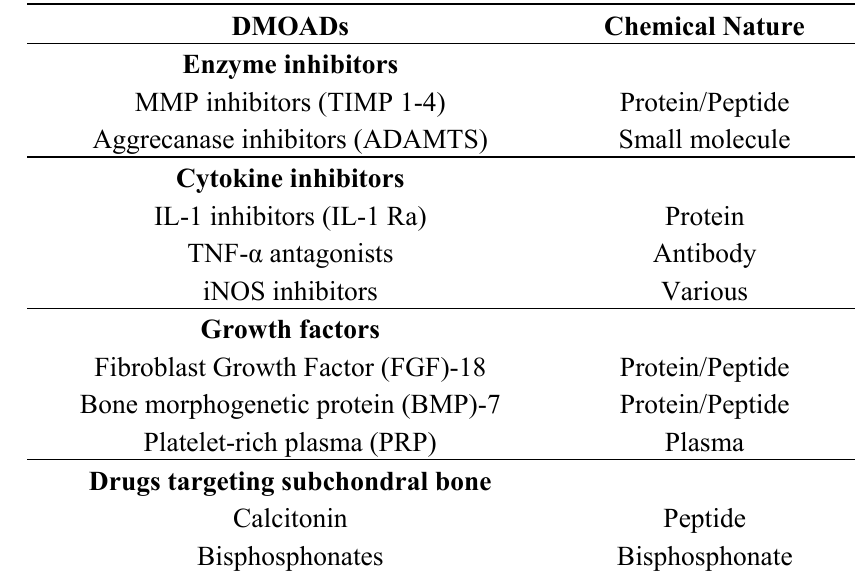
Table 2. Most investigated disease modifying osteoarthritis drugs (DMOADs), based on their target of action. The chemical nature of a DMOAD is important for incorporation in a